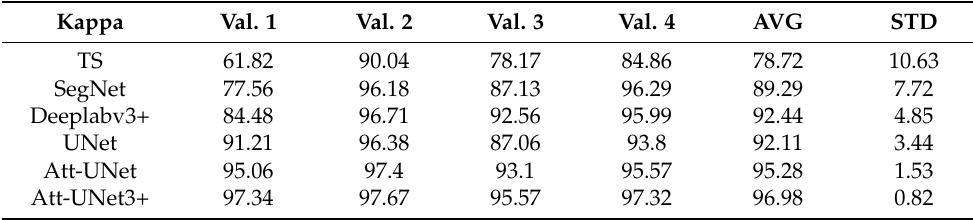
Table 4. Kappa results of different methods in each validation sample (%).